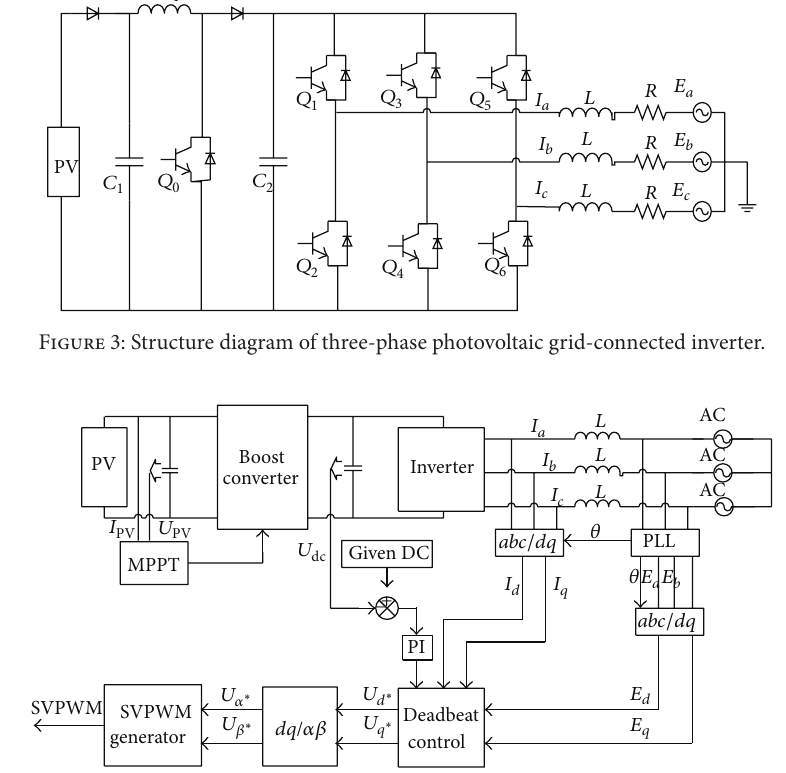
Figure 4: Structure of three-phase photovoltaic grid-connected